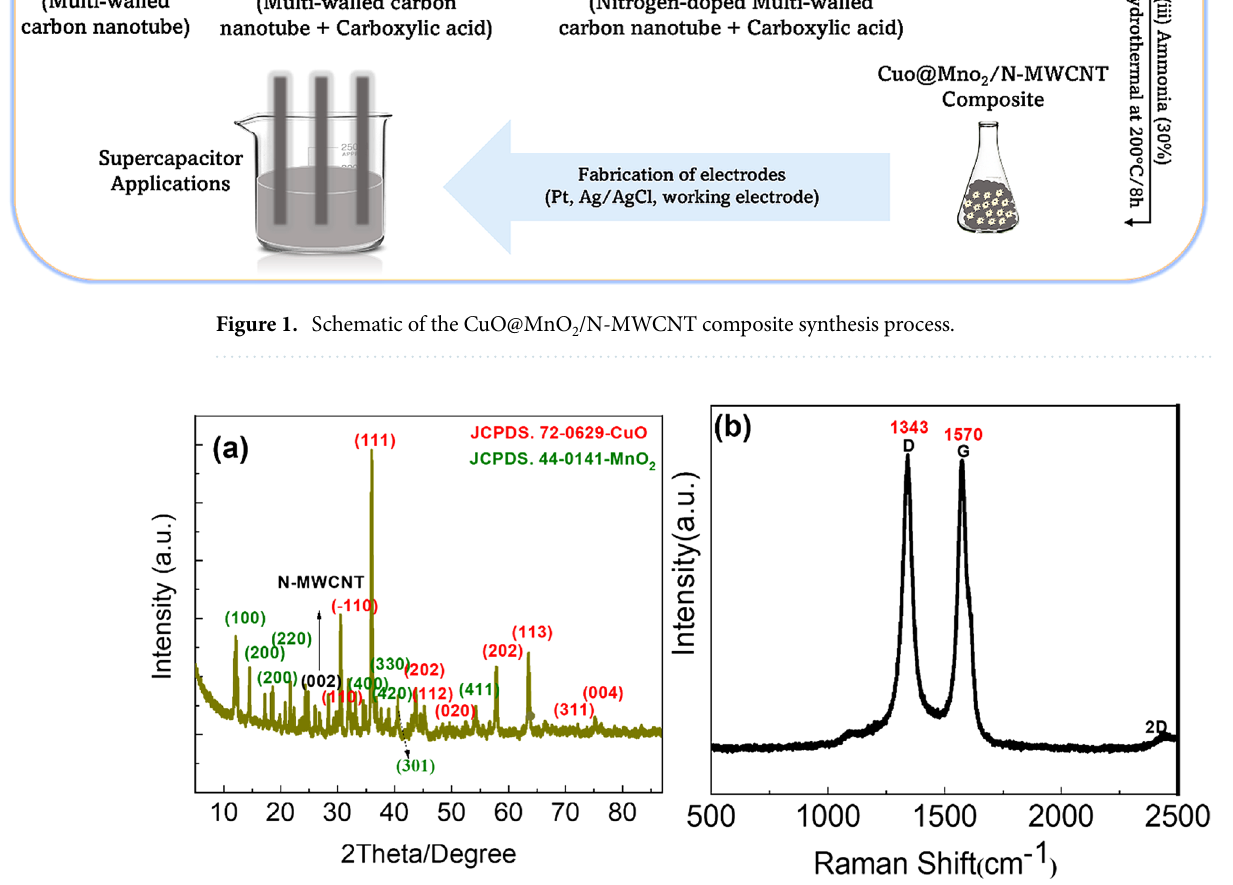
Figure 2. ( a ) XRD and ( b ) Raman spectra of the CuO@MnO 2 /N-MWCNT